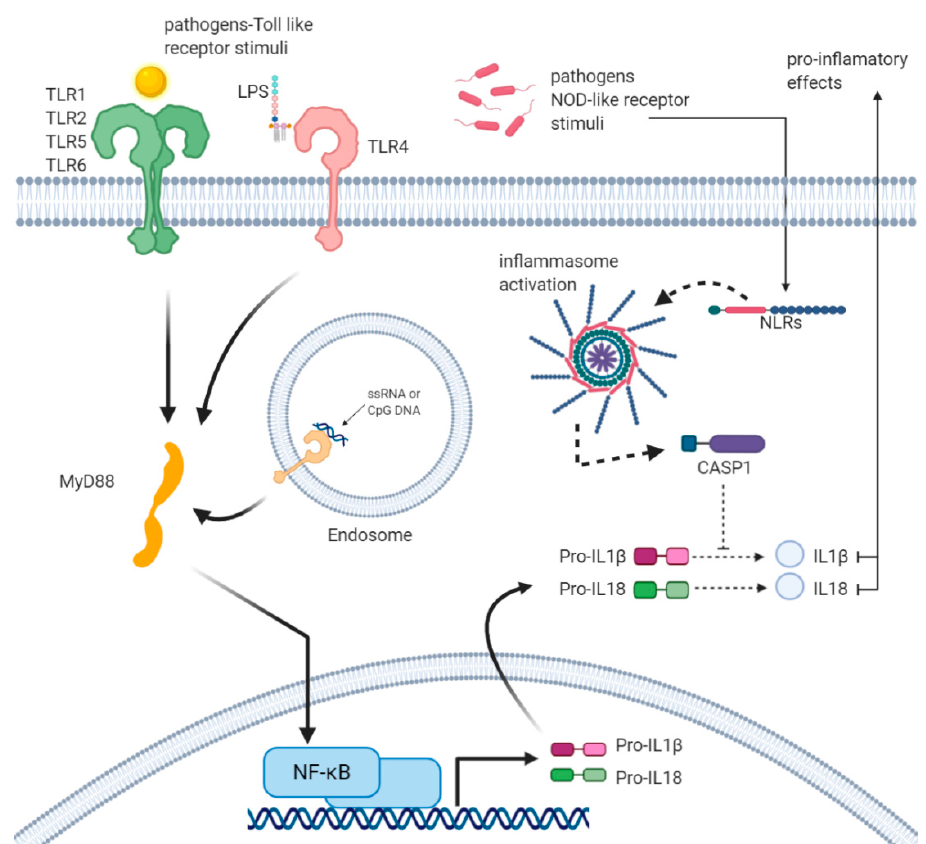
Figure 1. Inflammasomes activation and production of IL1 β and IL18: Surface-expressed TLRs, such as TLR1, 2, 5, and 6, bind TLR-dependent stimuli, for example bacterial PAMPs. Following this binding, TLRs, through the adaptor protein MyD88, activate the transcription factor NF- κ B to induce the expression of inflammatory genes, such as IL1 β and IL18, leading to the production of pro-IL1 β and pro-IL18. On the other hand, di ff erent PAMPs or DAMPs activate the inflammasome through various NLRs, such as NLRP3. Inflammasome leads to active Caspase-1 that processes pro-IL1 β / pro-IL18, leading to the active form of IL1 β and IL18. Active cytokines leave the cell and act as pro-inflammatory molecules.